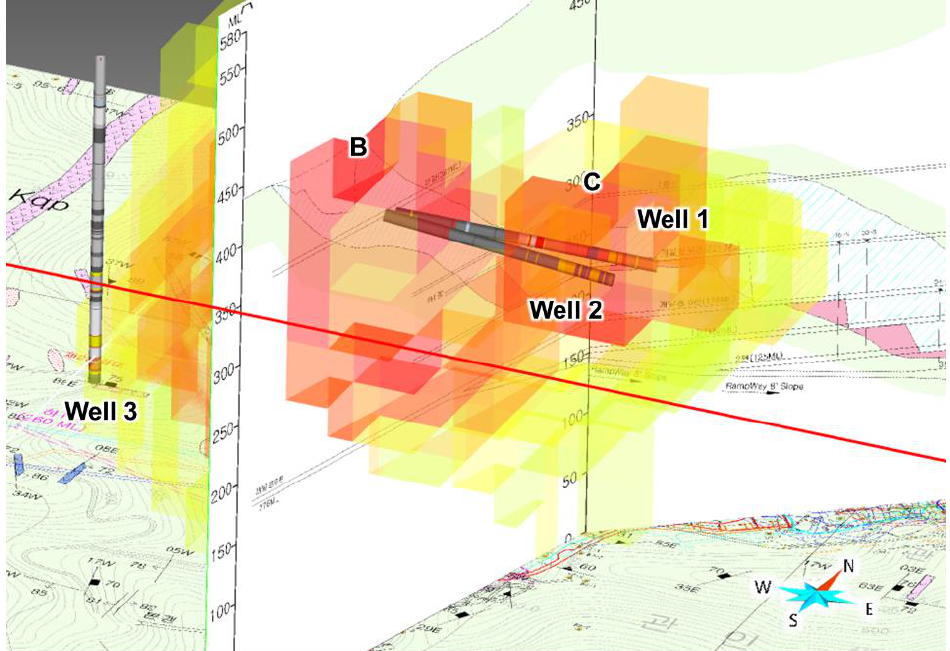
Figure 10. Drilling results shown overlaid on the inversion result of the aeromagnetic data acquired using the multicopter system.